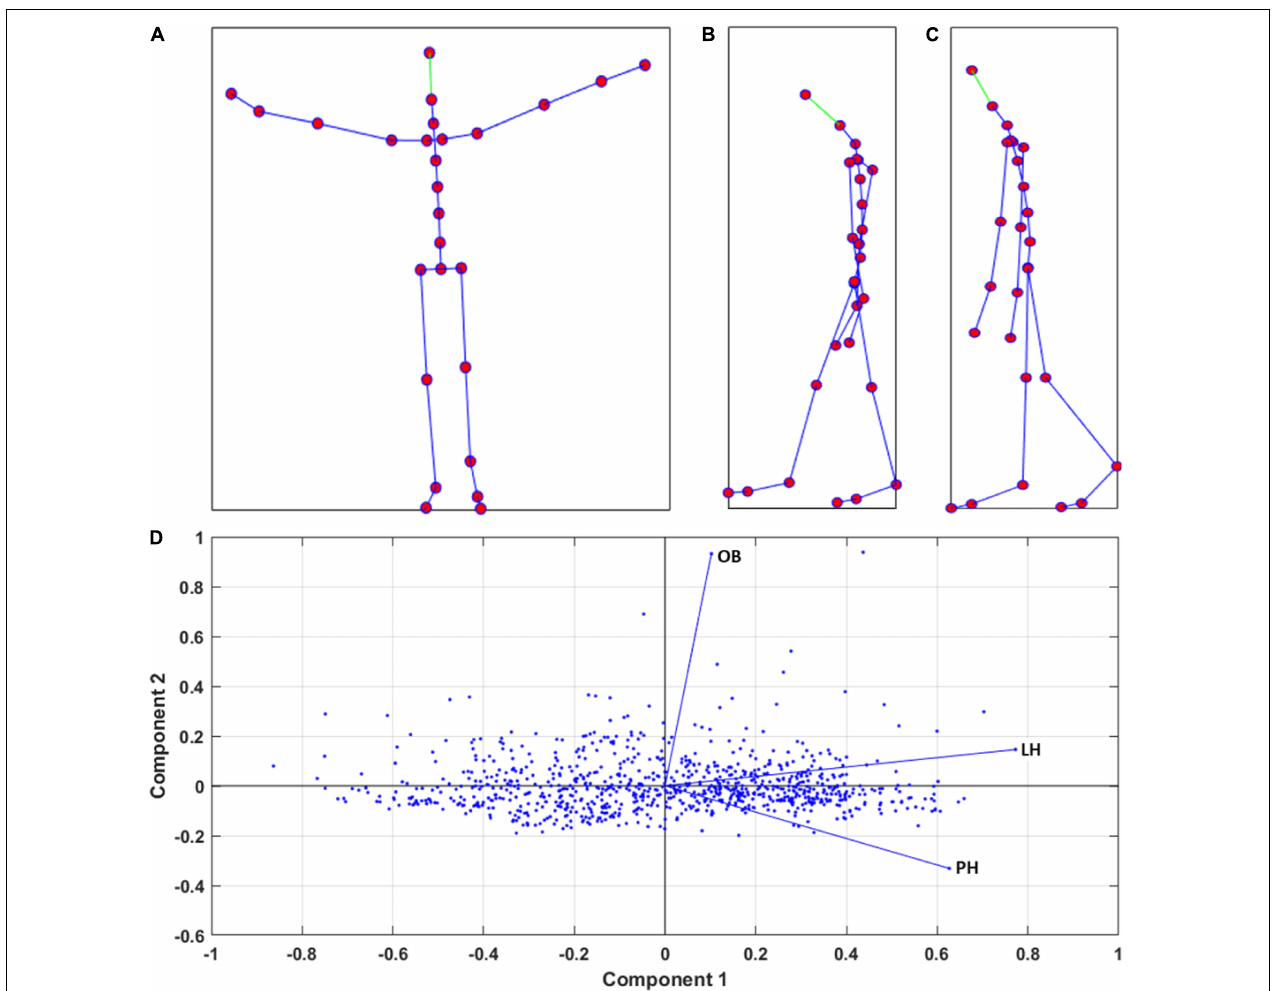
FIGURE 1 | Panels (A–C) show an example of body joints configurations (red dots) depicting a characteristic body posture for the body features OB, LH, and PH, respectively. Panel (D) displays the distribution of the 912 simple walking actions (blue dots) described by a particular score of OB, LH, and PH, over the plane composed by the Component 1 and Component 2 derived from the